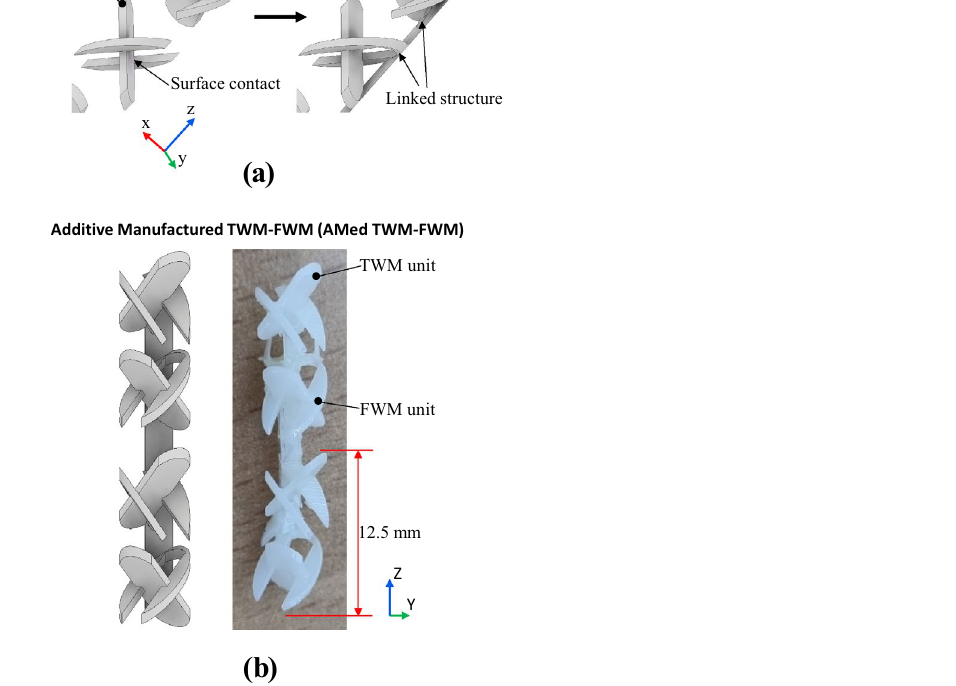
Figure 8. ( a ) Design modification for additive manufacturing. Linking structures between units are added, ( b ) the design geometry and the fabricated specimens of additive manufactured TWM-FWM (AMed TWM-